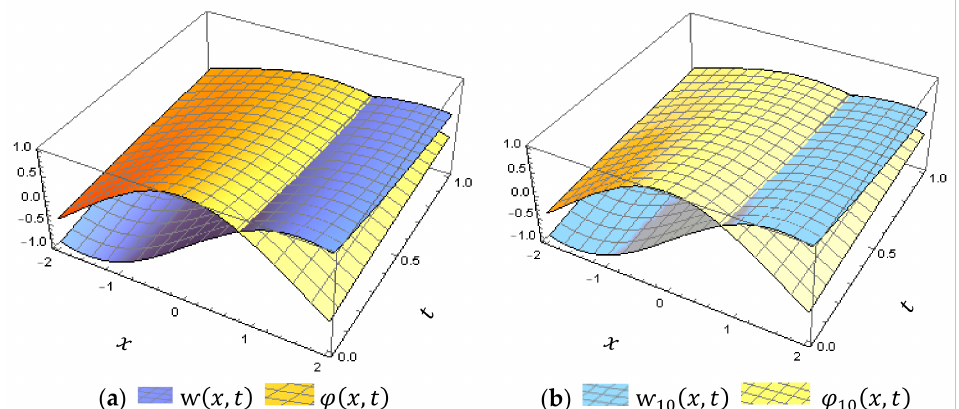
Mathematics 2021 , 9 , x FOR PEER REVIEW 3 of Figure 2. ( a ) 3D-surfaces plot of exact solutions